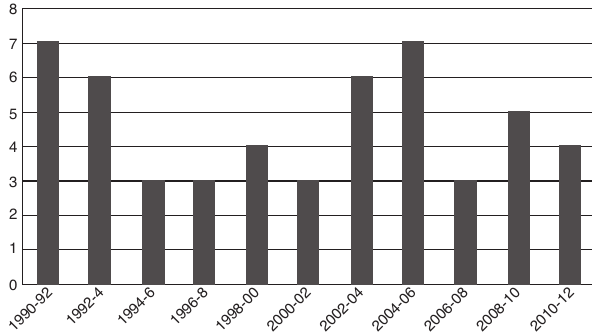
Figure 3 Occurrence of intracranial complications in 22 years divided in biennium. This bar graph demonstrates the relatively constant number of ICCs seen in OM over 22 years, despite advances in antibiotic treatment over that same time frame.